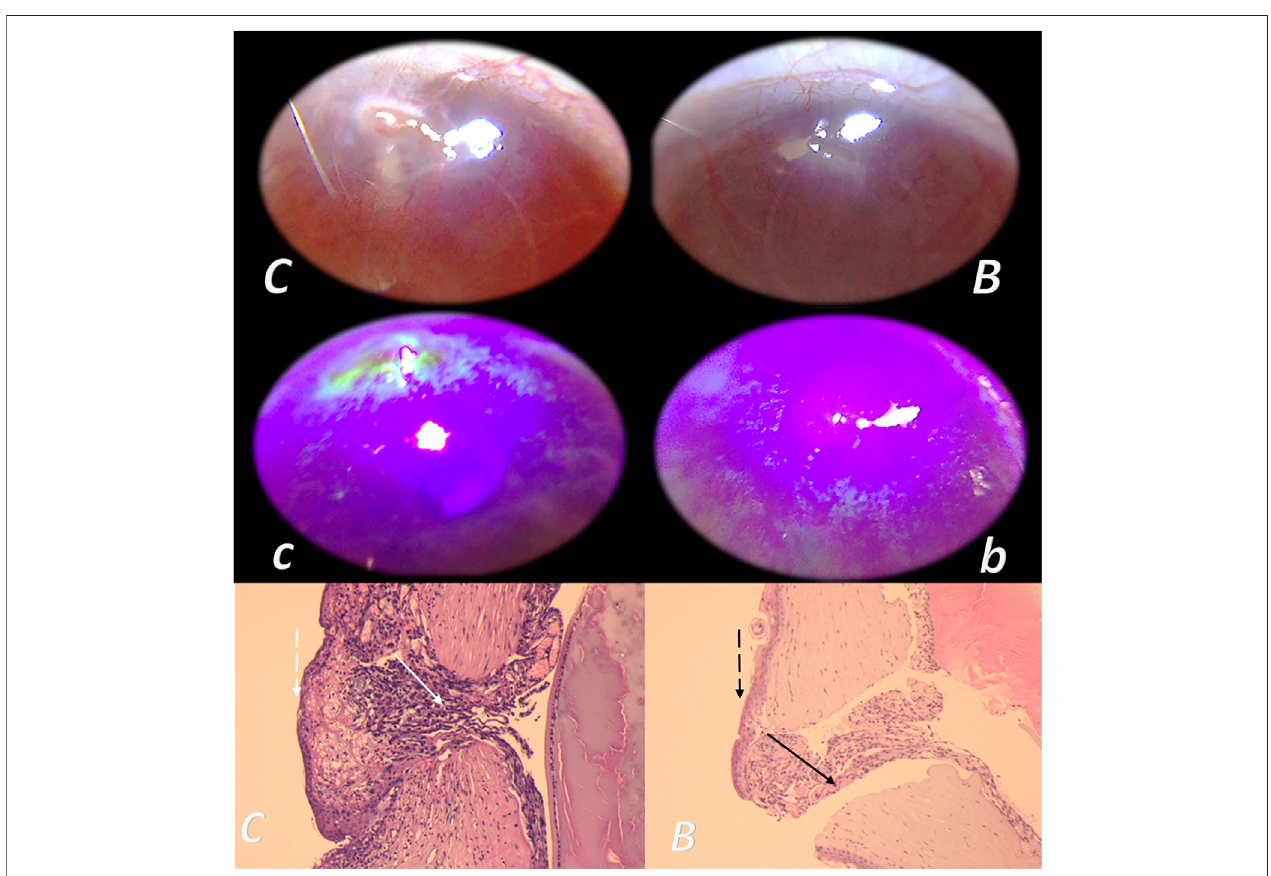
FIGURE 14 | Corneal ulcer and BPC 157 therapy, ophathalmoscopy and microscopy presentation (Masnec et al., 2015). In deeply anesthetized rats, a penetrant linear 2-mm incision was made and two drops of 0.4% oxybuprocaine topical anesthetic were given (to inhibit possible eyelid re fl ex) in the paralimbal region of the left cornea at the5o ’ clock positionwitha20-gaugeMVRincision knife at45 ° under anoperating microscope. BPC157wasdissolved indistilled waterat 2 pg/ml, 2 ng/ml, and 2 μ g/ml, and two eye drops were administered to the left eye in each rat immediately after induction of the injury and then every 8 h up to 120 h; controls receivedanequalvolumeofdistilledwater.Characteristicmicroscopypresentation(HE,x4)at48 hafterinjuryinductionincontrolratswasmuchwidergap,notmaturing and abundant granulation tissue, edematous with a lot of fi brin (clot-like) at the surface (white arrow). The surface epithelium is relatively unorganized and progressing over the gap showing a basal cell-like morphology ( C ) (dashed white arrow). In BPC 157 – treated animals, the perforation channel is narrow, partly fi lled with well- vascularized butmaturing,non-edematous granulationtissue (blackarrow). Thesuper fi cialepitheliumprogressingover thegap looksstrati fi ed( B )(dashedblackarrow).